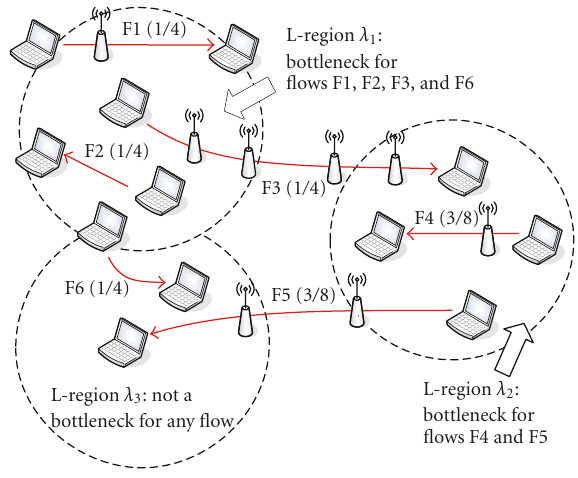
Figure 2: The output of the C-load share assignment algorithm.